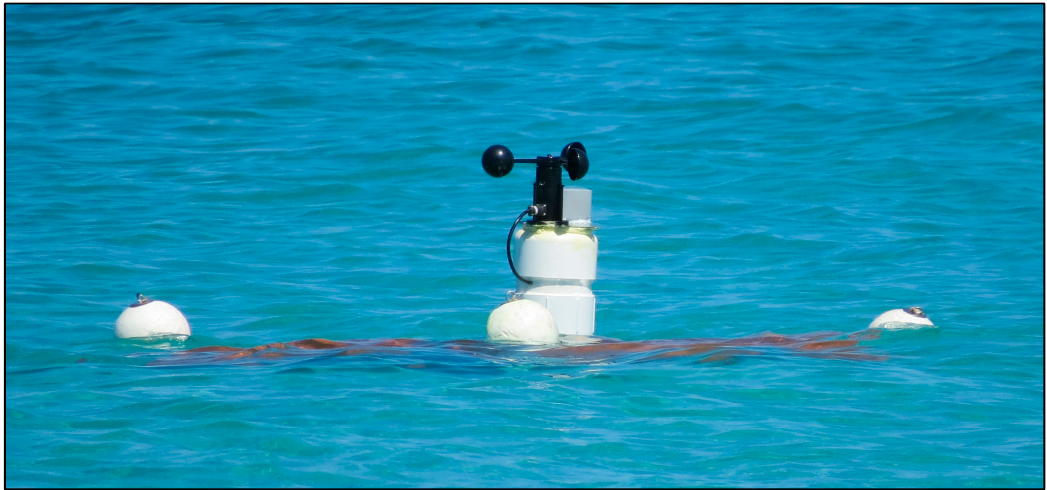
Figure 14. Drifting Davis buoy placed in El Tecolote (Mexico) beach for environmental data collecting.